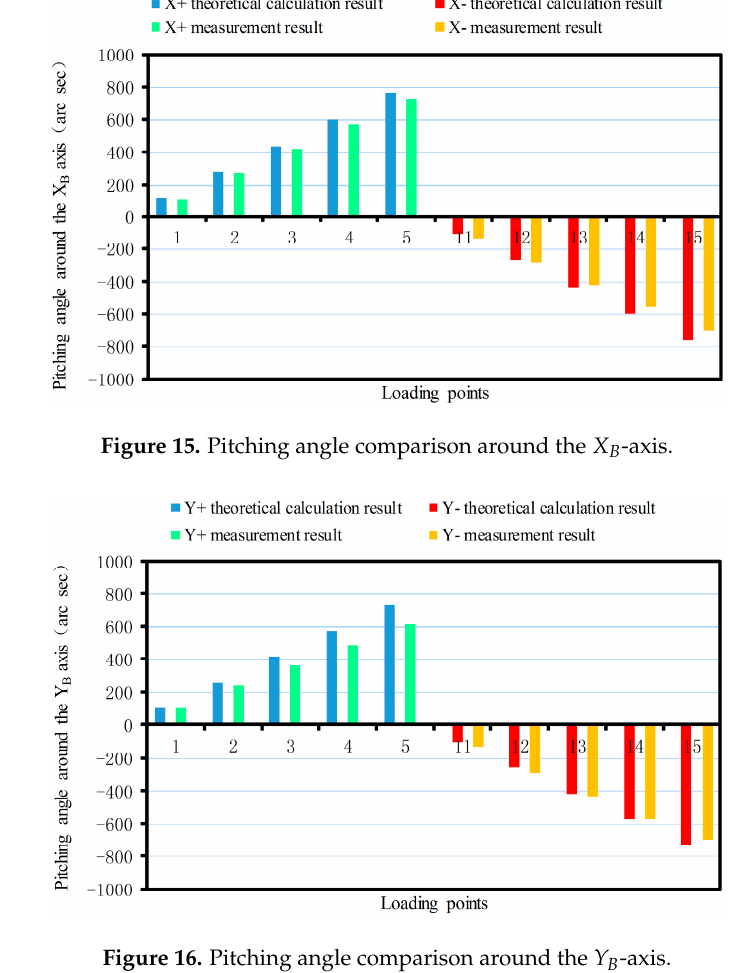
Figure 16. Pitching angle comparison around the Y B -axis.